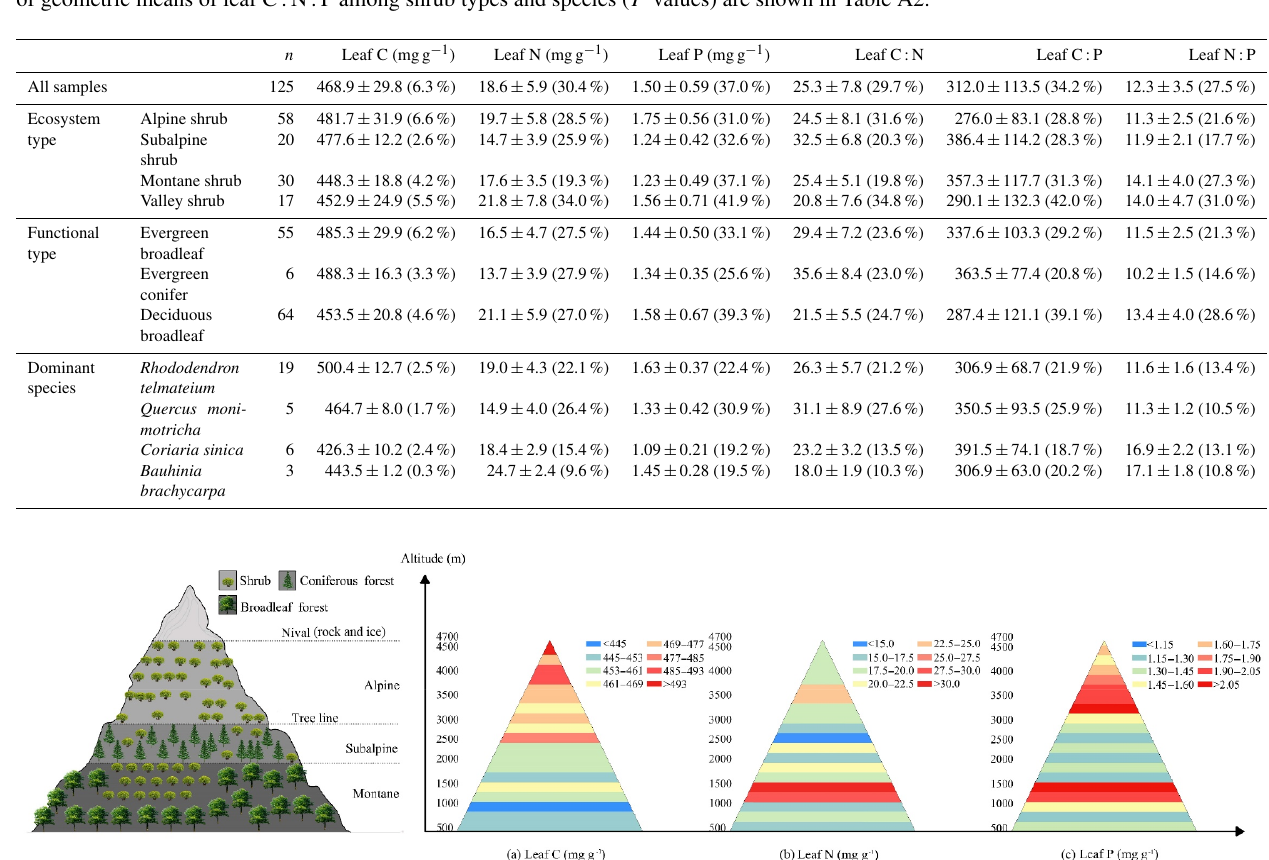
Table 1. Geometric means and standard deviations of leaf element concentrations and ratios for all shrub samples, and specific shrub type and species on the Tibetan Plateau. Ecosystem types include shrubs that located at different altitudinal belts. Functional types are classified based on different leaf traits. Coefficients of variation (CV, %) are in parentheses. n represents the number of shrub samples. Comparisons of geometric means of leaf C:N:P among shrub types and species ( P values) are shown in Table A2.